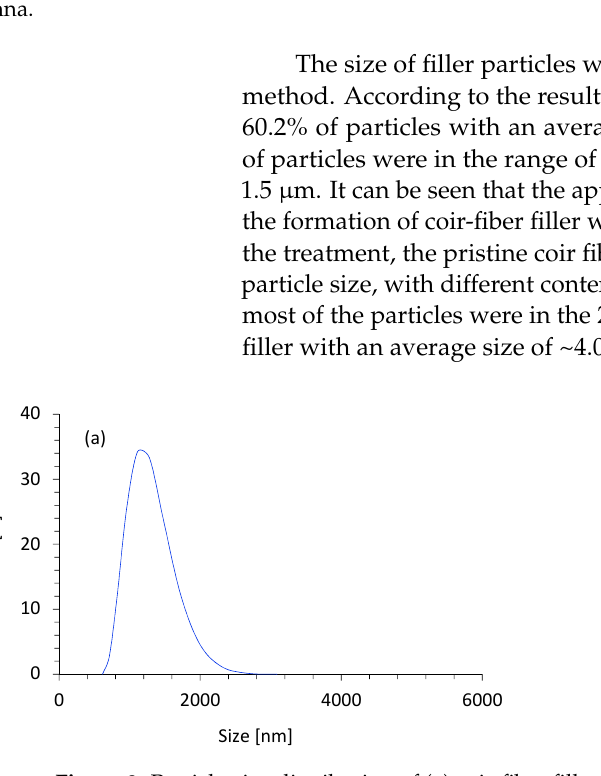
Figure 3. Particle-size distribution of ( a ) coir-fiber filler modified with henna and ( b ) pristine coir fibers.